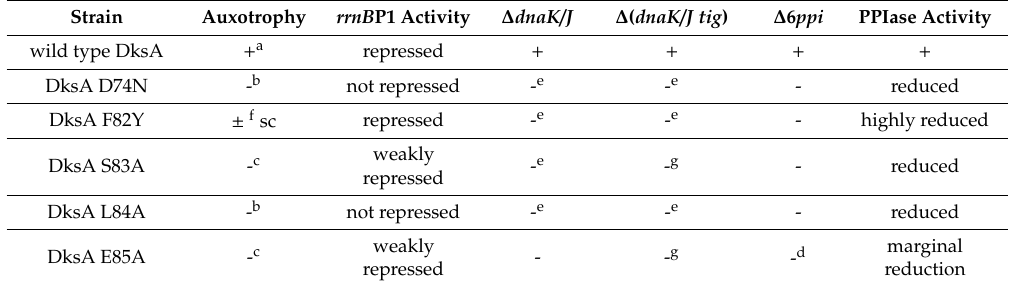
Table 5. Properties of various DksA mutants in terms of suppression of auxotrophic phenotype of a ∆ dksA strain, the suppression of Ts phenotype and impact on the PPIase